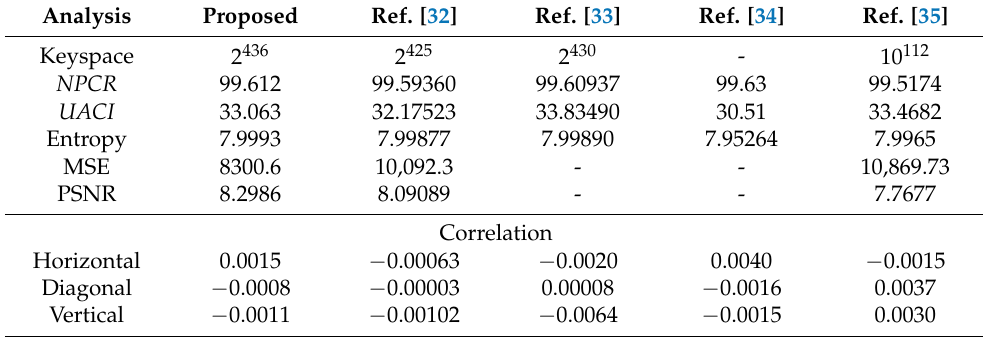
Table 8. The contrast of statistical calculations of the suggested method with existing